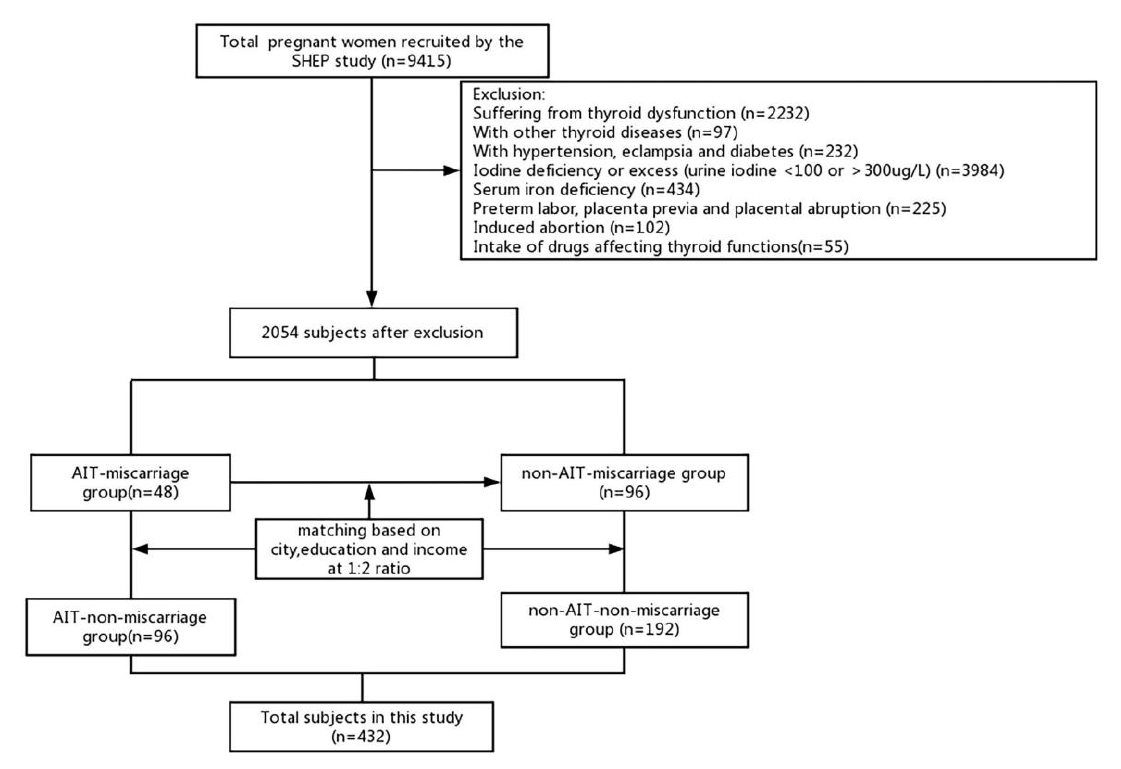
Figure 3. The enrollment flowchart of all the euthyroid participants in the current study.